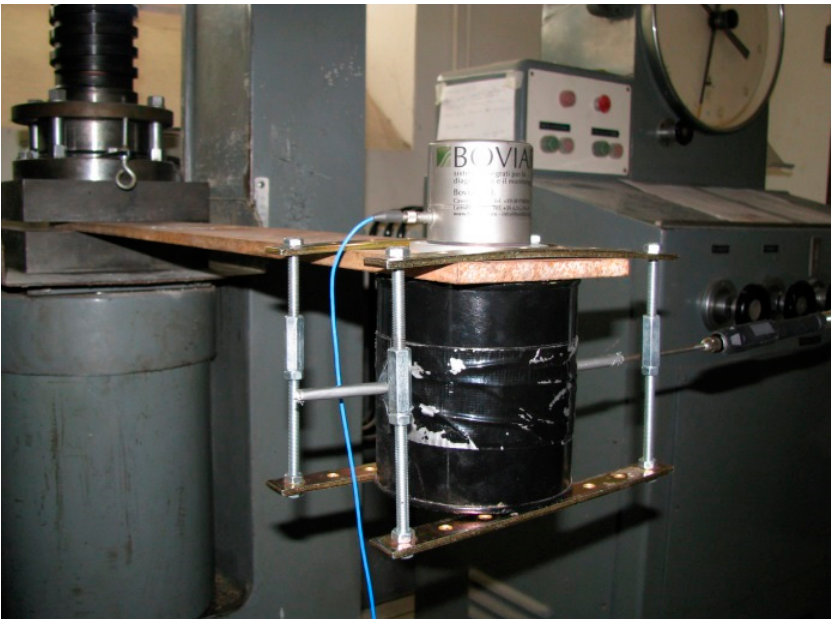
Figure 9. Cantilever beam experimental tests scheme. The vibrodyne is on the bottom while the accelerometer is on the top side of the free end.